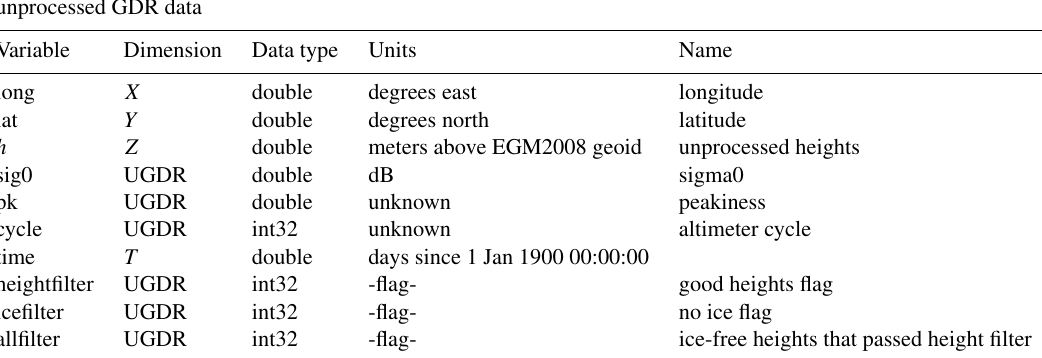
Table A2. This includes the data from each return: long and lat, the height of the water level in meters, the signal strength, sigma0, in decibels, a “peakiness” value, the cycle number, the time of the return, and filter flags that signal 1 for data that should be included and 0 for data that should be excluded. The flags are for a height filter, an ice filter, and the logical intersection of the two (allfilter), with 1 denoting returns that pass through the filter and 0 denoting returns that do